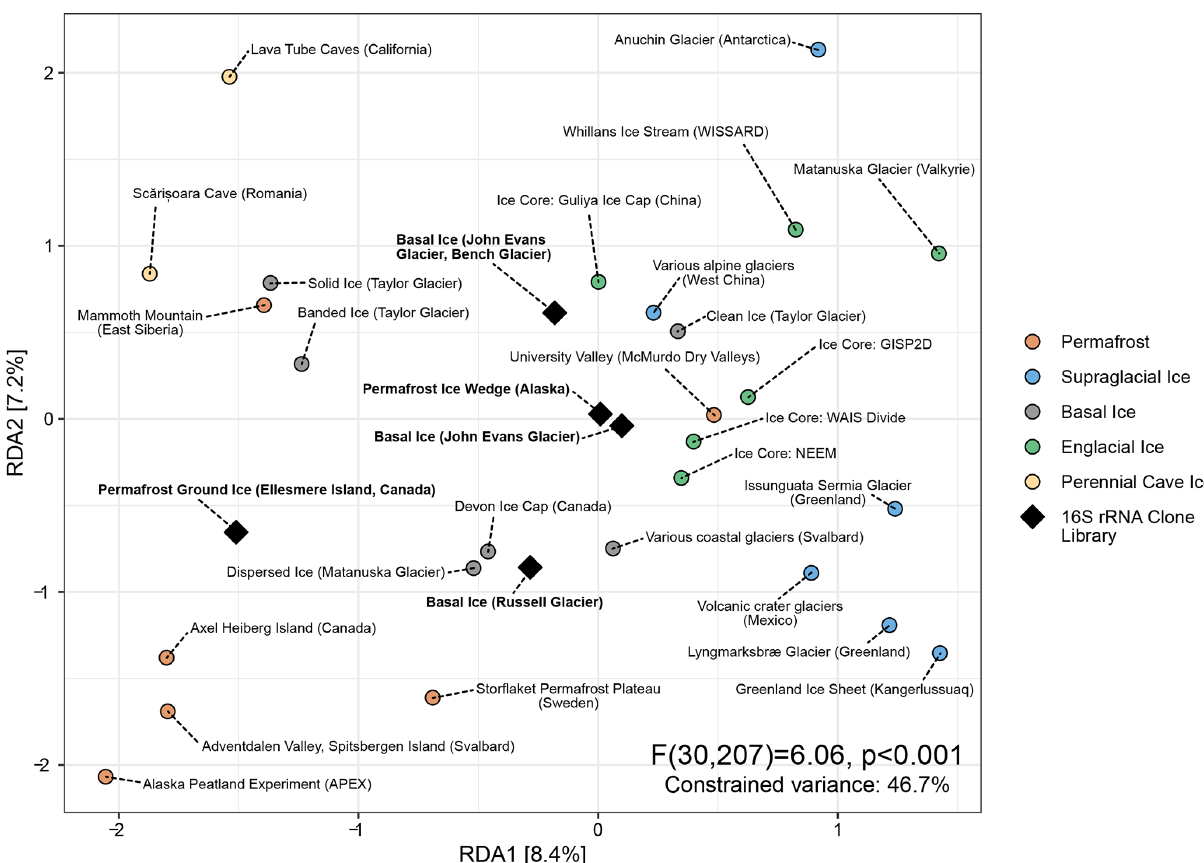
Figure 5. Distance-based redundancy analysis of Aitchison distances between different perennially frozen environments. Colored circles represent centroids of each study’s samples. Black diamonds represent individual early studies of basal ice and permafrost based on Sanger sequencing of 16S rRNA clone